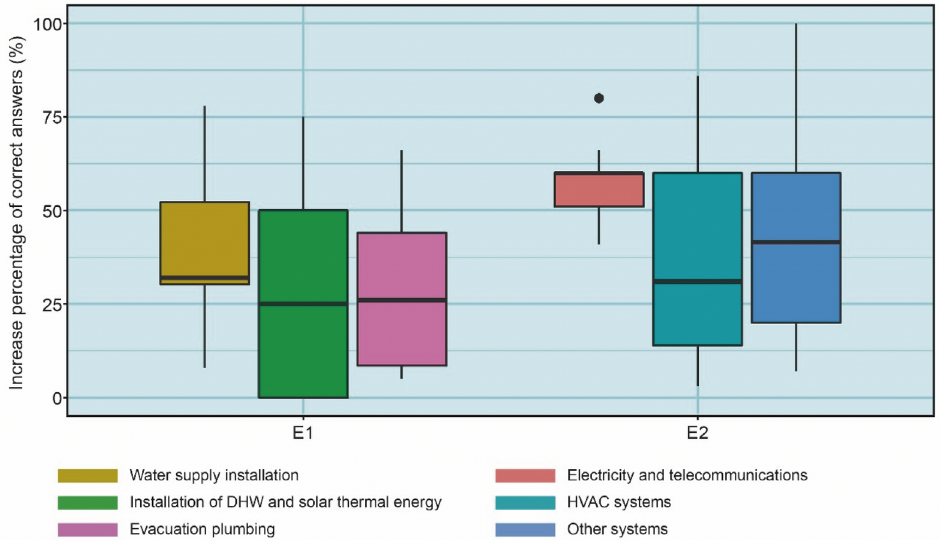
Figure 3. Increase percentage of correct answers in the final exam, compared to Kahoot!